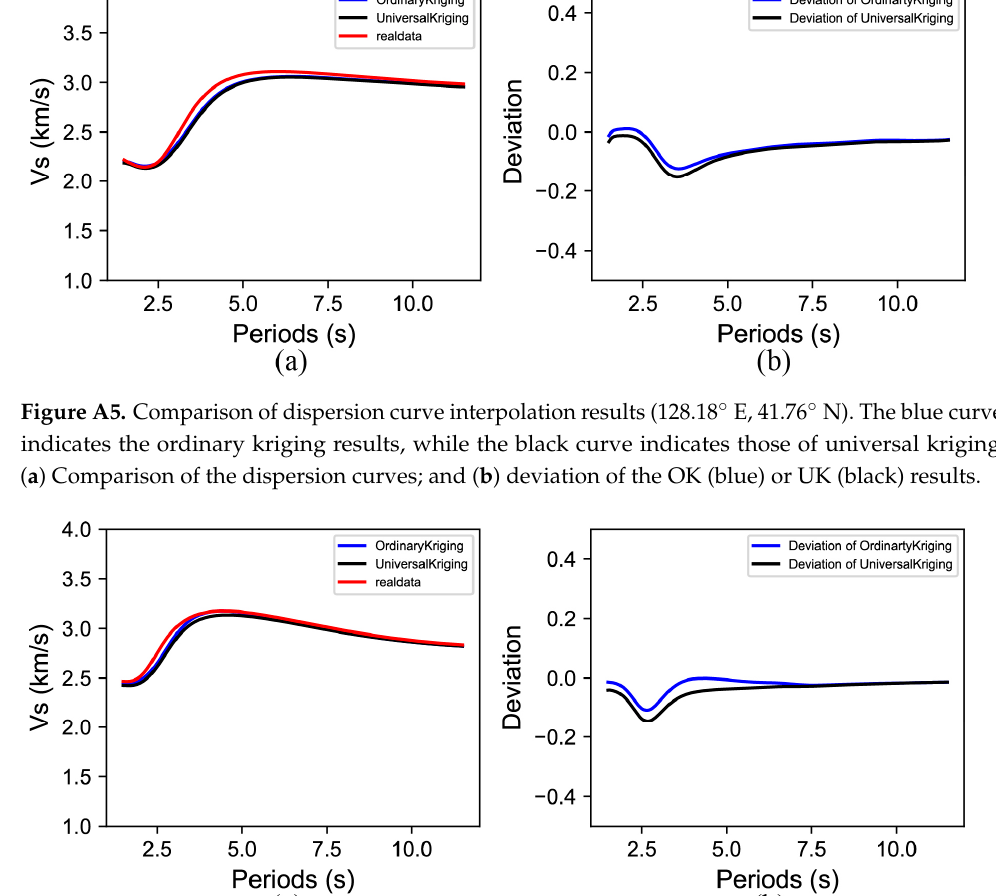
Figure A4. Comparison of dispersion curve interpolation results (128.09° E, 41.88° N ). The blue curve indicates the ordinary kriging results, while the black curve indicates those of universal kriging: ( a ) Comparison of the dispersion curves; and ( b ) deviation of the OK (blue) or UK (black) results.